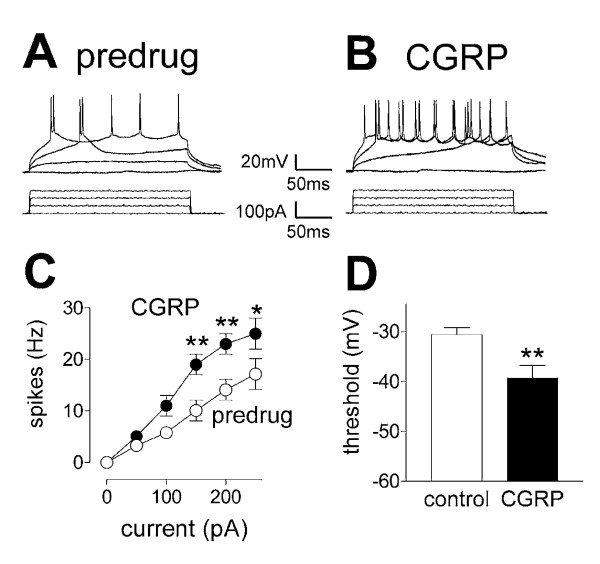
CGRP increases neuronal excitability and induces direct membrane currents. A, B, Current-clamp recordings of action potentials (spikes) generated in an SG neuron by direct intracellular injections of depolarizing current pulses of increasing magnitude (0 to 250 pA; 500 ms) before (A) and during CGRP (10 nM, B). C, CGRP increased input-output function by significantly increasing spike frequency (n = 5 neurons; P < 0.05–0.01, two-way ANOVA followed by Bonferroni posttests). For the measurement of action potential firing in current-clamp, neurons were recorded at -60 mV. D, CGRP (10 nM) also decreased spike thresholds (membrane potentials at which action potential firing started) significantly (n = 5; P < 0.01, paired t-test). * P < 0.05, ** P < 0.01.